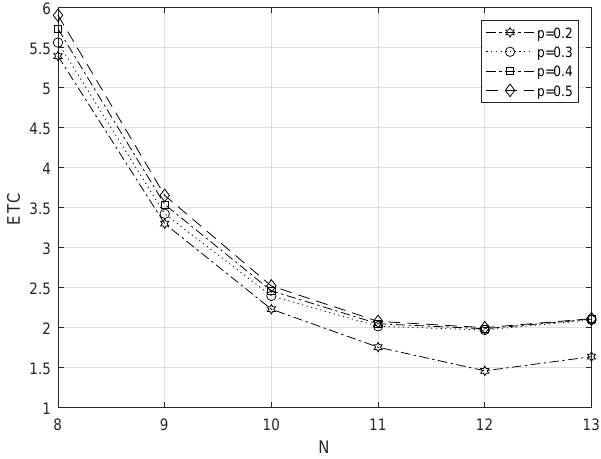
Figure 5. The impact of ETC when N vs p for SAM.